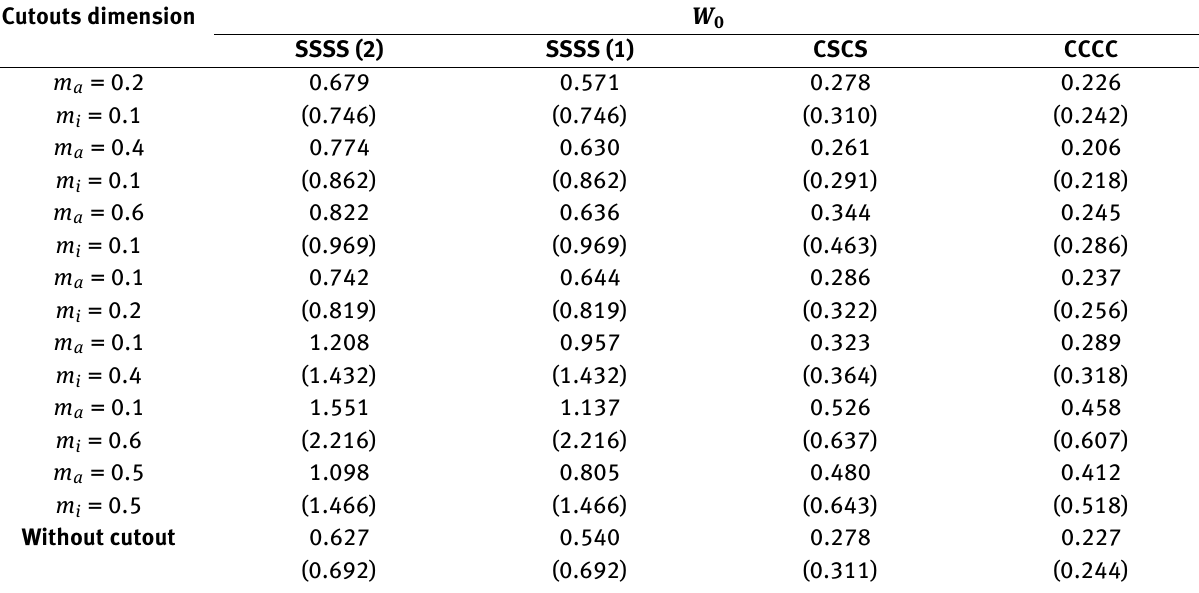
Table 6: Effect cutout dimensions with various support conditions on the NTMD of laminated (45/ − 45/C/45/ − 45) sandwich square plate Cutouts